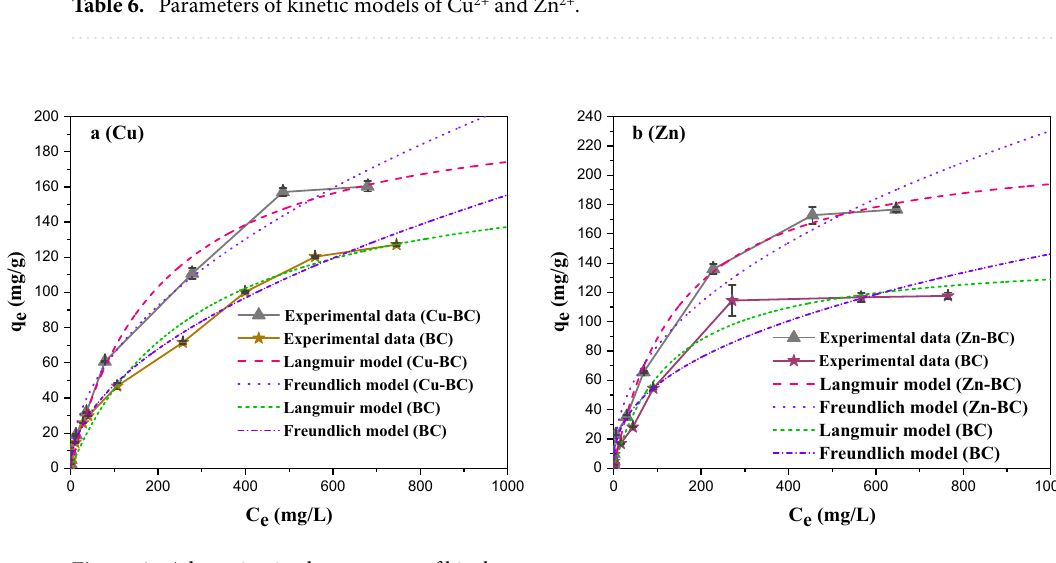
Figure 6. Adsorption isotherm curves of